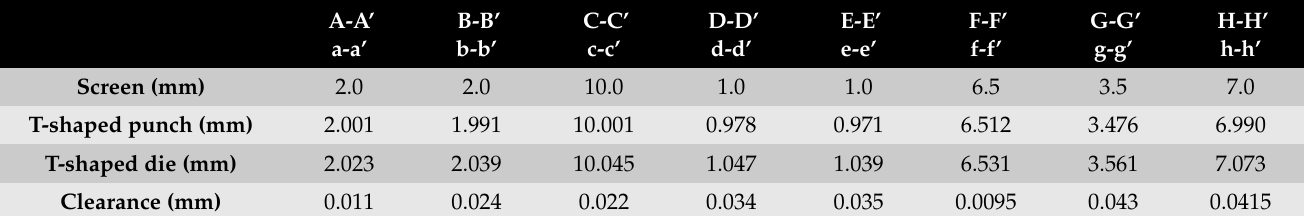
Table 1. The measured widths of T-shaped punch head and die cavity in Figures 9 and 10 with reference to the CAD data of screen films.